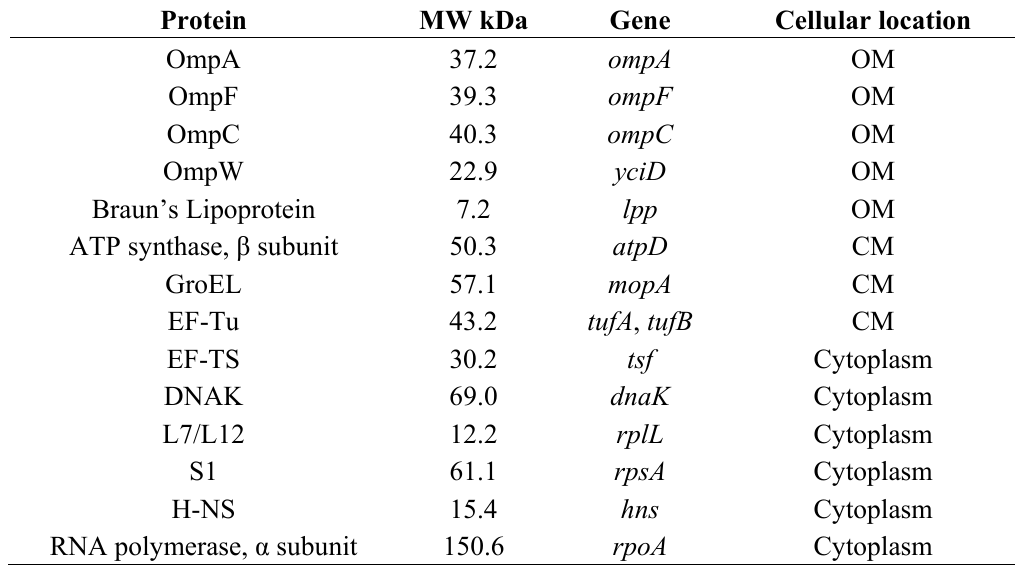
Table 1. cPHB proteins in E. coli lysates were identified by two-dimensional electrophoresis followed by Western blot analysis using anti-PHB IgG. OM—outer membrane; CM—cytoplasmic